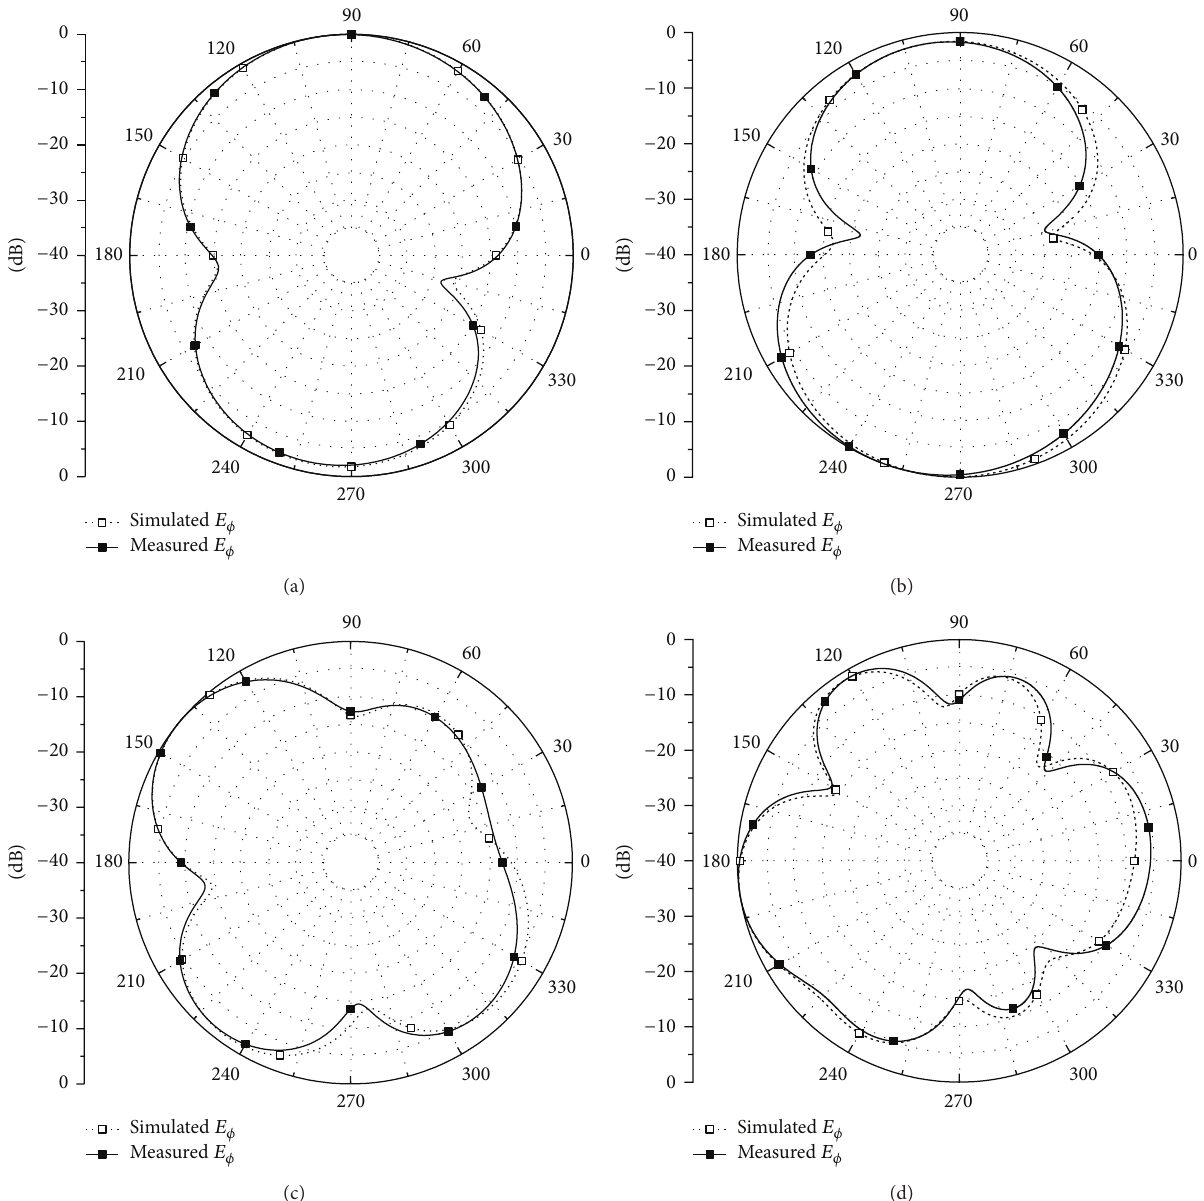
Figure 14: Simulated and measured radiation patterns of the proposed antenna ( 𝑋𝑌 -plane): (a) 800 MHz, (b) 920 MHz, (c) 1950 MHz, and (d) 2600